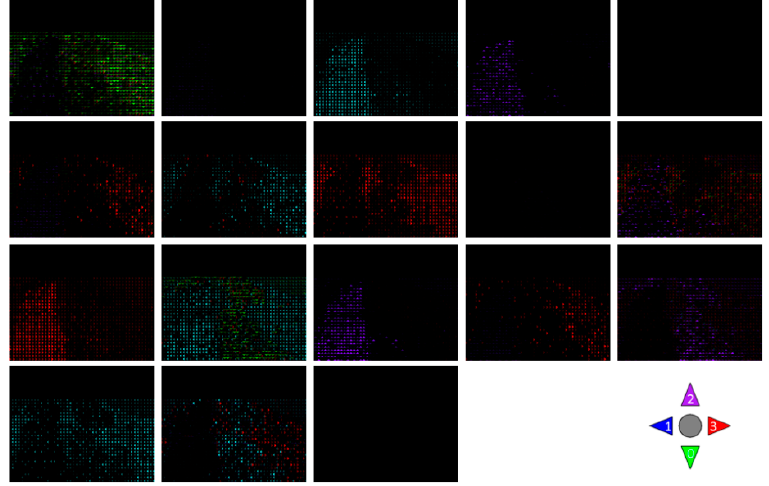
Figure 13. Eighteen latent motion topics discovered by RTM-GS on longer burn-in time.